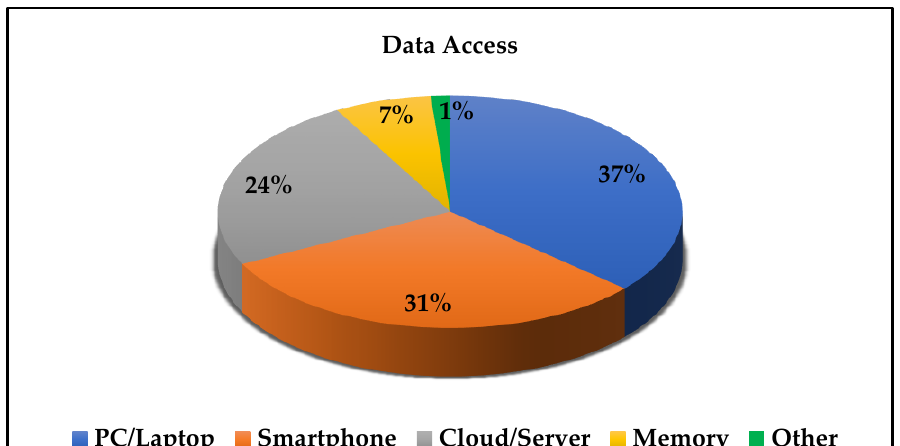
Figure 5. Distribution of the used data access technologies.